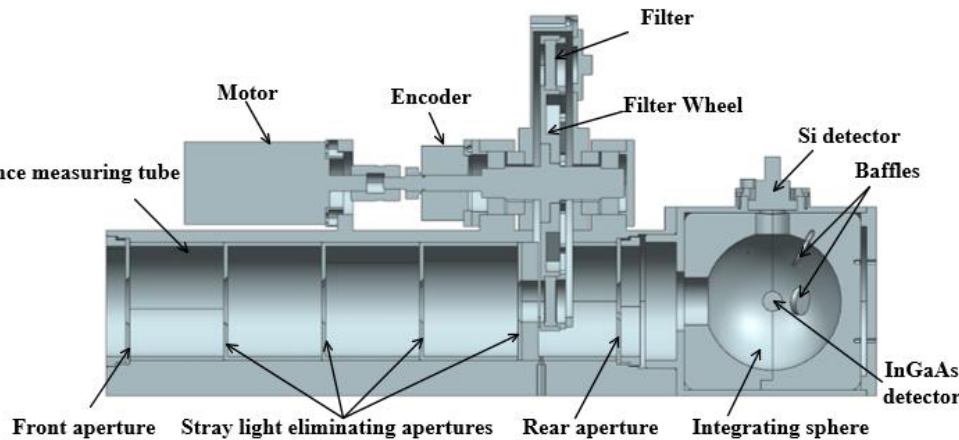
Figure 3. Sectional view of the transfer